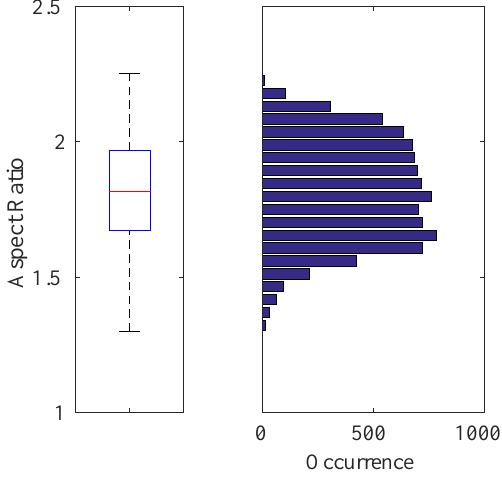
Figure 7. Box-plot ( Left ) and histogram ( Right ) representation for the aspect ratios of 8876 quadrotor images automatically extracted from the training videos. In this figure and the subsequent box-plot figures, the top and bottom edges of the box and the line inside the box represent the first and third quartiles and the median value, respectively. The bottom and top whiskers correspond to the smallest and largest non-outlier data, respectively. The data inside the box lie within the 50% confidence interval, while the confidence interval of the data in between the whiskers is 99 . 3% . Here, the median value is 1 . 8168 , which defines the aspect ratio of the training images used.